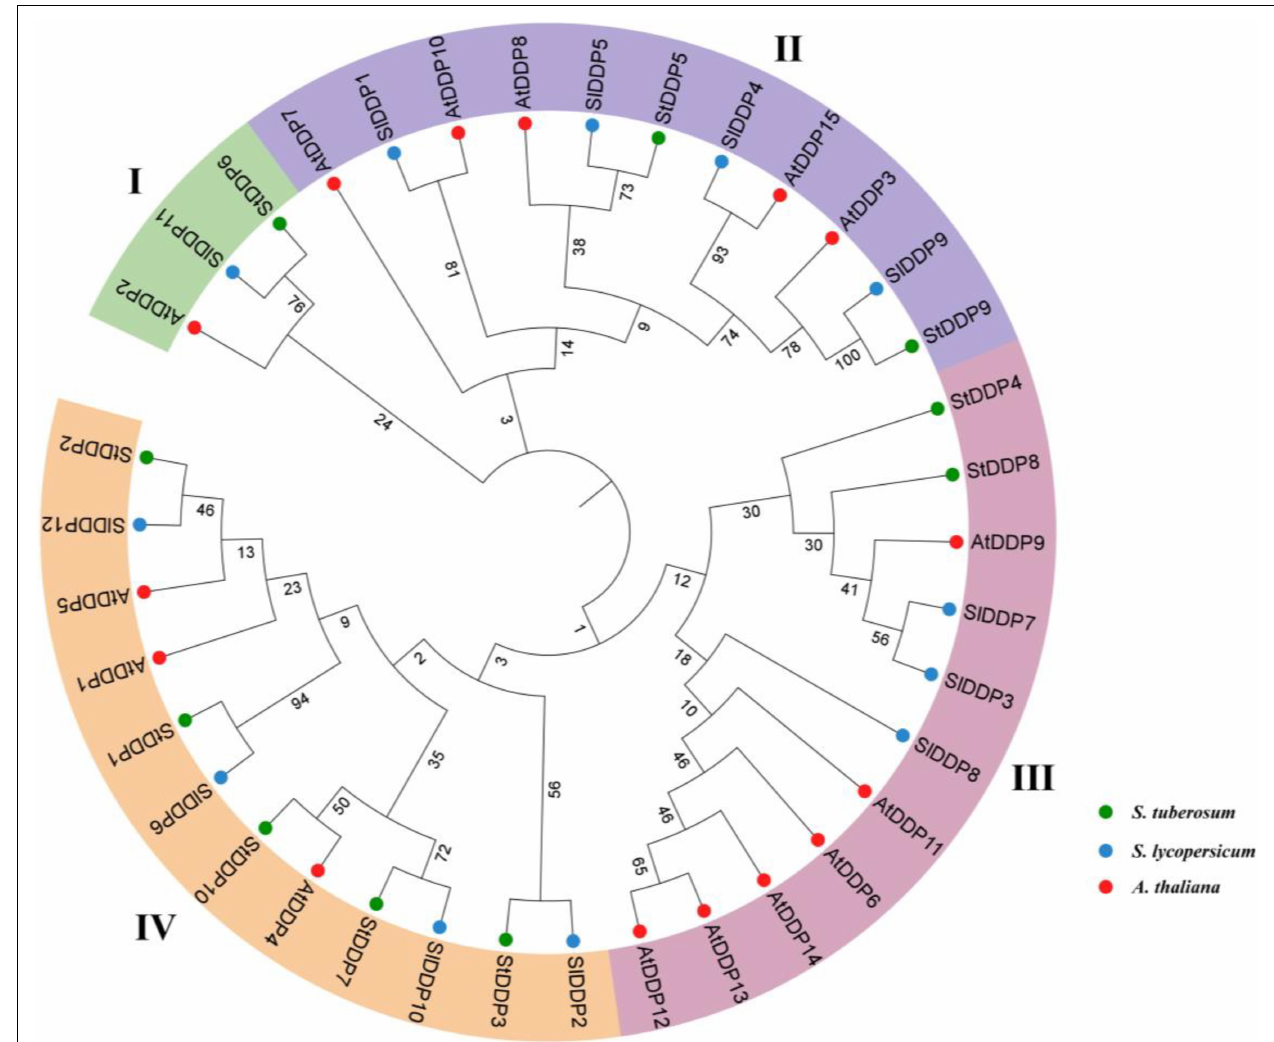
FIGURE 1 | Phylogenetic tree of deafness-dystonia peptide (DDP) proteins from Arabidopsis, Solanum lycoperiscum , and Solanum tuberosum . The colored arcs indicate different groups. The stars’ colors, represent proteins of Arabidopsis S. lycoperiscum , and S. tuberosum .